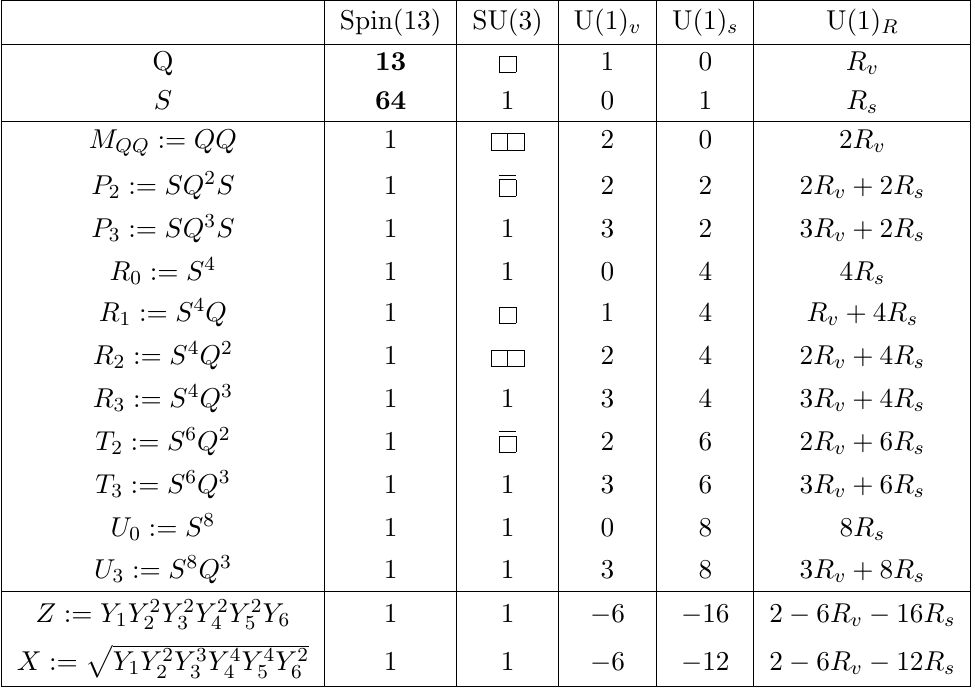
Table 23 . 3d N = 2 Spin(13) theory with ( N v ; N s ) = (3 ;